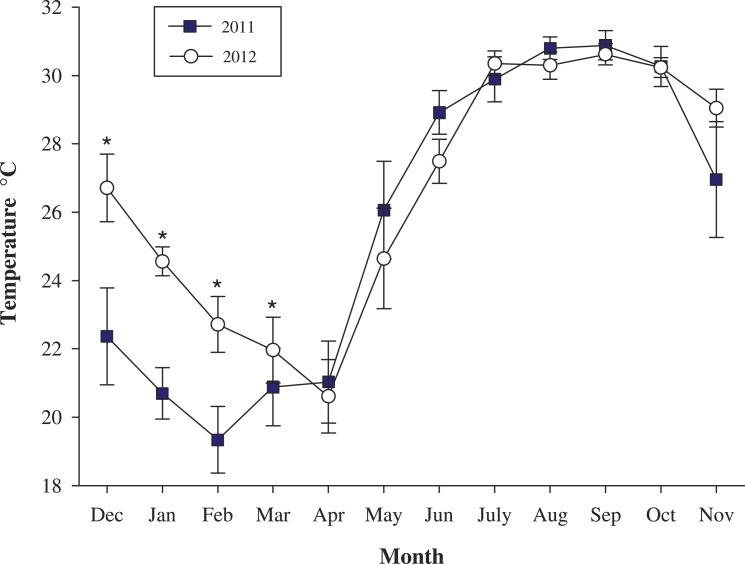
Mean monthly (±SD) sea surface temperatures (SST).Comparisons of La Niña (ENSO) and normal SST period. La Niña period, shaded squares and Non-ENSO period, open plots. ∗ Statistical differences, P =  < 0.001.